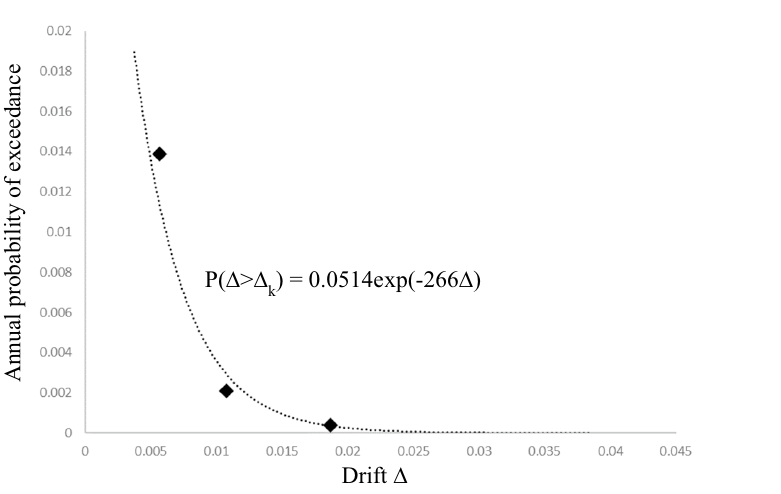
Figure 6. Samples of pushover curves.